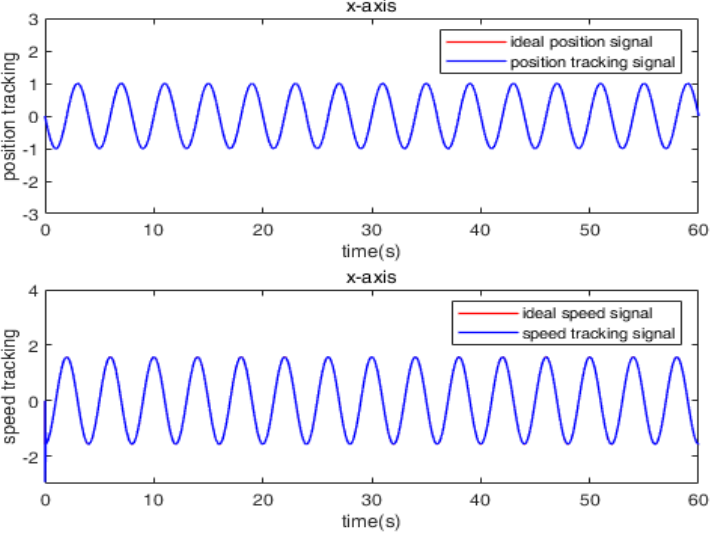
Figure 5. Position tracking and speed tracking of the x -axis under NFTSMC-GRFNN.